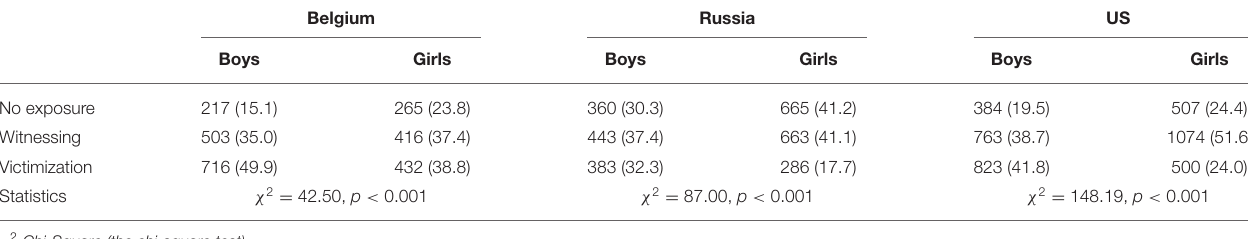
TABLE 1 | Within-country comparisons of community violence exposure by gender [ N (%)].